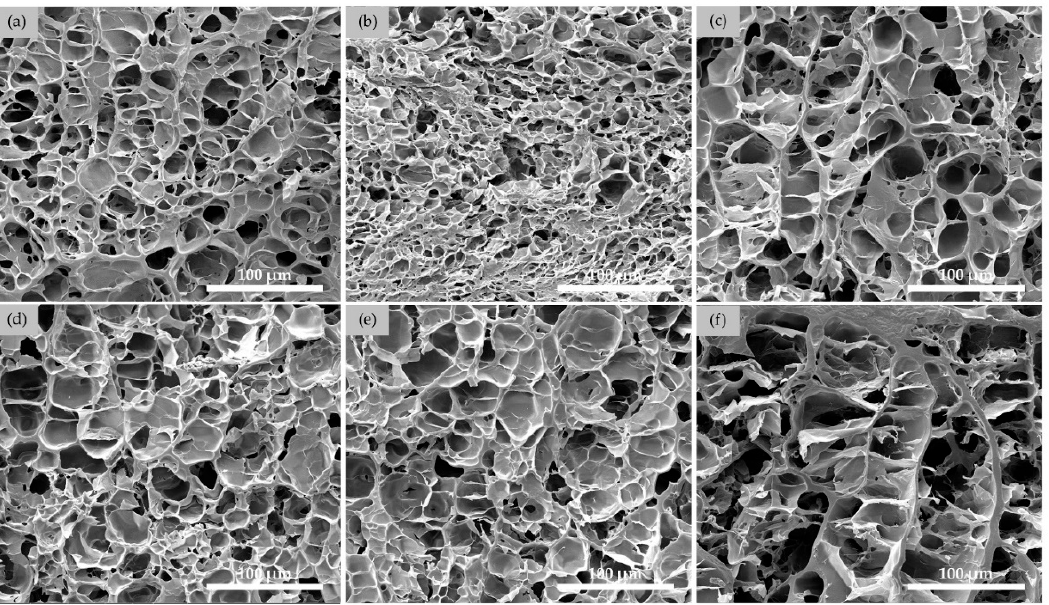
Figure 2. SEM micrographs of cross-sections of SN starch hydrogels containing 30 mL of GA content (SN30), at various crosslinking times (1000× of magnification): ( a ) 2 h, ( b ) 4 h, ( c ) 6 h, ( d ) 8 h, ( e ) 10 h and ( f ) 24 h.